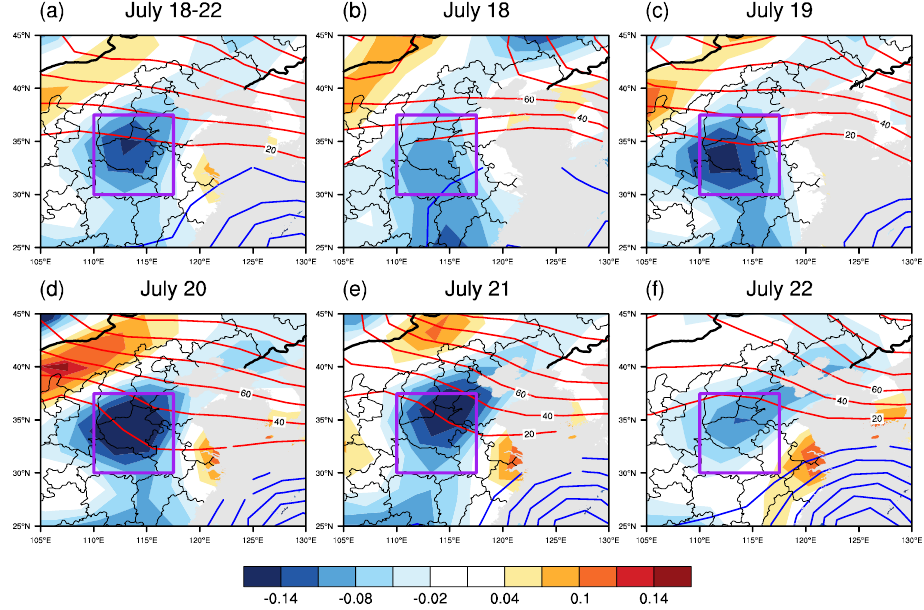
Figure 4. Same as Figure 3, but for the 500 hPa geopotential height (contour, unit: gpm) and vertical velocity anomalies (shading, unit: p/s). ( a ) The average and ( b – f ) the daily variation during 18 – 22 July 2021, respectively.